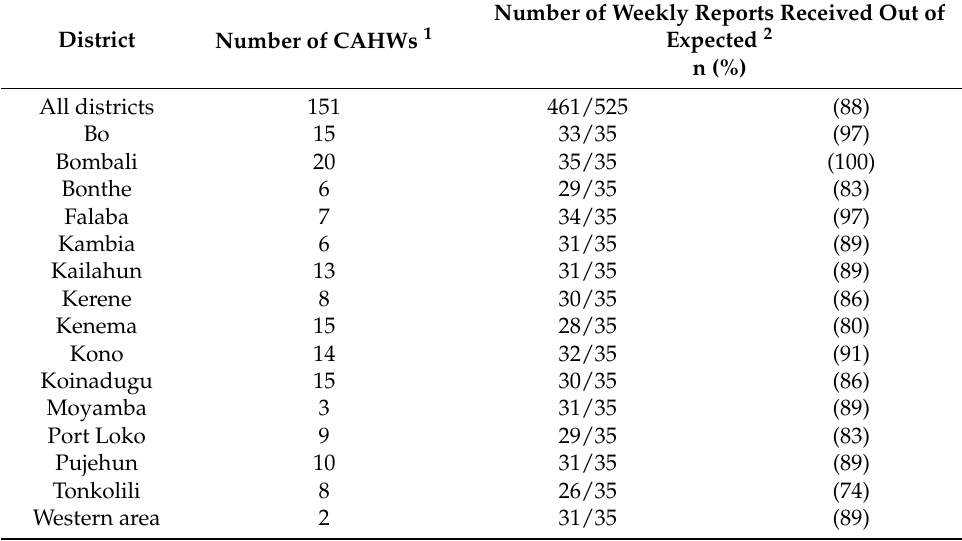
Table 1. The number of Animal Health Weekly Reporting forms expected and available per district in Sierra Leone, March–October 2021.